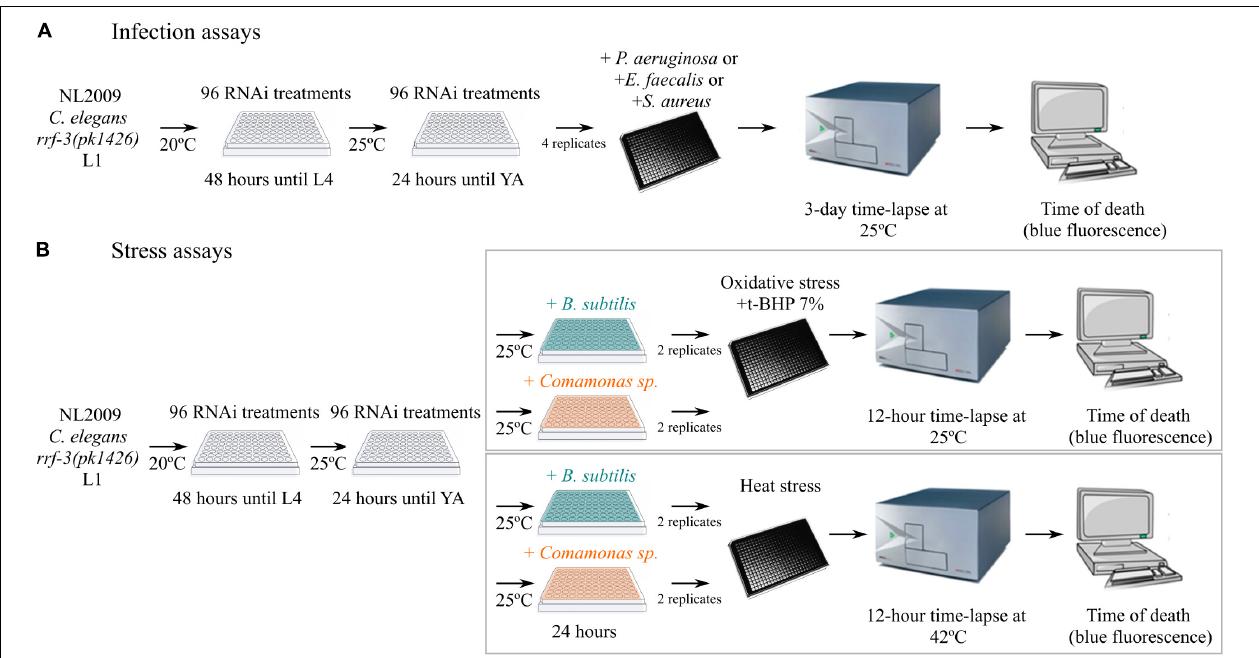
FIGURE 4 | Schematic representation of approach to screen Hedgehog-like (HHL) genes and genetic interactors by RNAi inactivation. For all assays the RNAi-sensitive C. elegans strain NL2009 was used. Time of death was detected by blue death fluorescence as established in the Label-Free Automated Survival Scoring (LFASS) method (Benedetto et al., 2019). (A) Shows details of the approach for infection with P. aeruginosa , E. faecalis, and S. aureus and (B) shows details of the approach for the oxidative stress assay with 7% t-BHP and the heat stress assay at 42 ◦ C. Before the stress assays, RNAi-treated worms were exposed for 24 h at 25 ◦ C to commensal G- ( Comamonas sp.) and G + ( B. subtilis ) stress-protective bacterial isolates. YA, Young